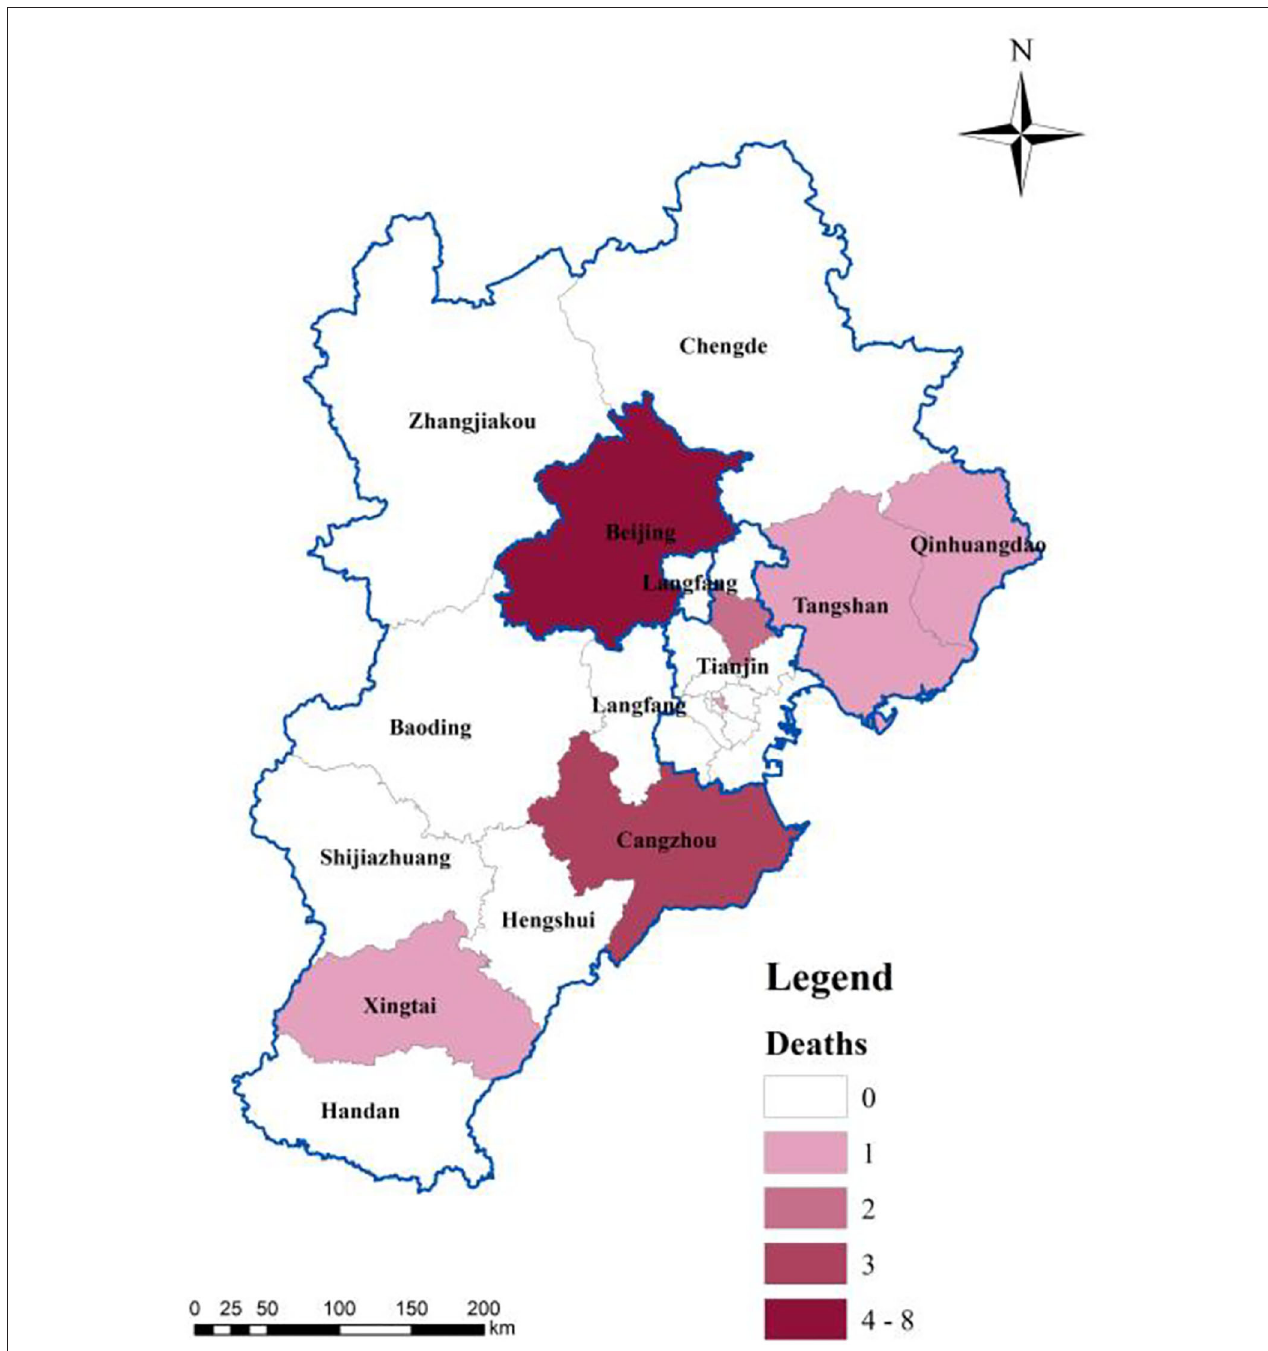
FIGURE 6 | Spatial distribution of deaths.